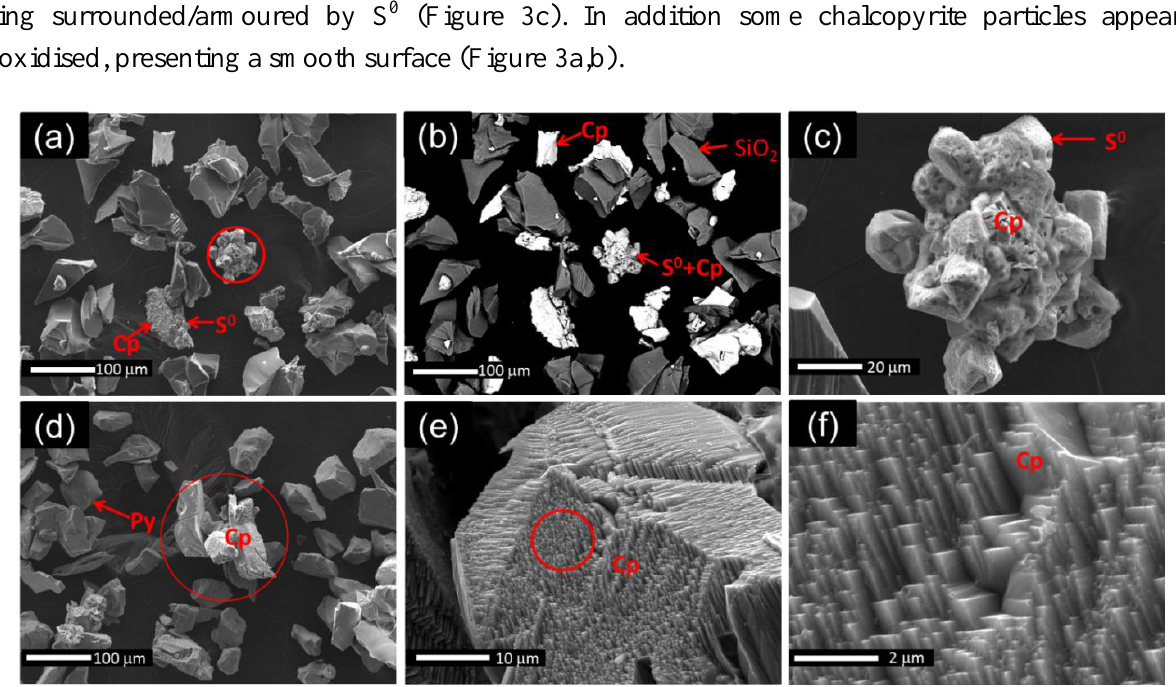
Figure 3. SEM images of leach residues collected at the end of the experiment, 132 days, (750 mV, 75 °C and pH 1.0 shown in Figure 1): ( a ) full view of chalcopyrite dissolved with quartz (SE image); ( b ) full view of chalcopyrite dissolved with quartz (BSE image); ( c ) selected area from ( a ); ( d ) full view of chalcopyrite dissolved with pyrite (SE image); ( e ) selected area from ( d ); ( f ) selected area from ( e ). Cp—chalcopyrite, S 0 —elemental sulfur, SiO 2 —quartz,